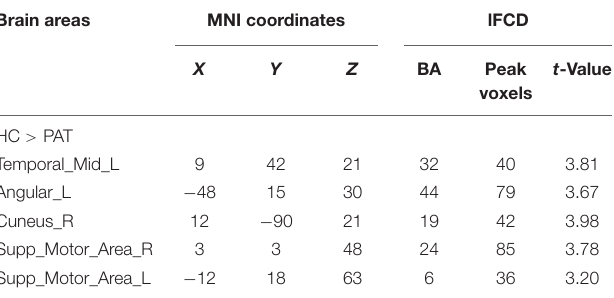
TABLE 3 | Binarized IFCD differences between the ON and HC